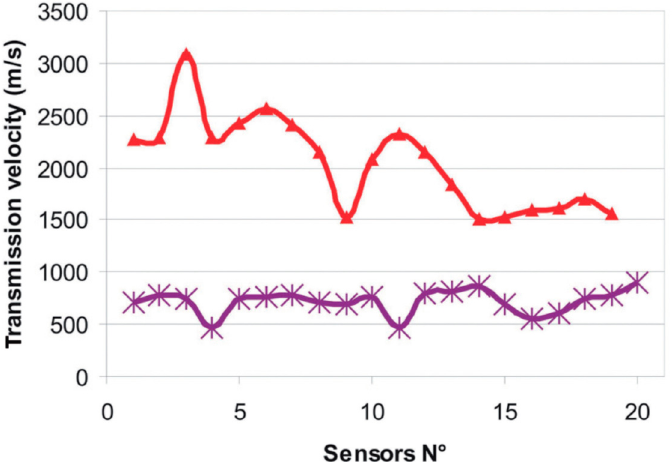
Figure 4. Results of acoustic techniques applied in-situ to the assessment of efficiency of grouting, Katholikon of Dafni Monastery, Athens, Greece. Sonic transmission velocities across a similar wall grouted (red, higher velocity in repaired areas) or not yet grouted (purple, lower velocity in the presence of cracks and voids), showing the assessment capabilities of the technique. After Côte & X. Dérobert et al. [69] (reprinted with copyright permission).